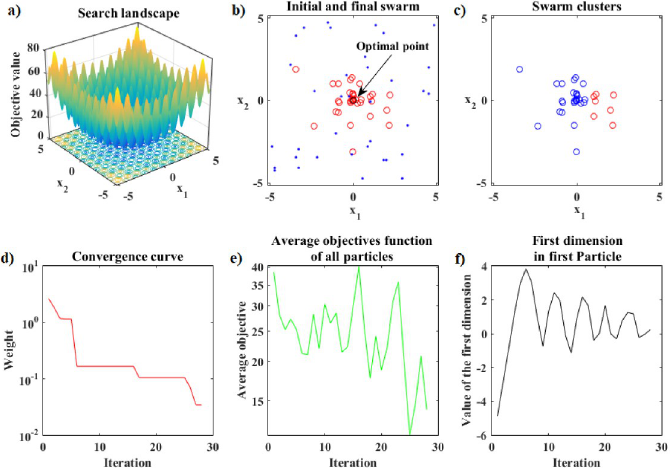
Fig 10. Rastrigin function. Details of the optimization process of the PSO-Kmeans-ANMS algorithm in Phase 1 for the stopping criterion based on the ratio between the sizes of the clusters.